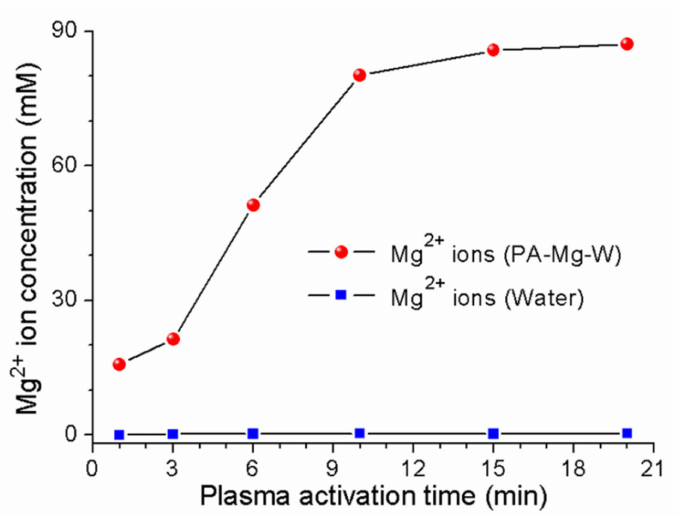
Figure 4. Mg 2 + ion concentrations in PA-Mg-W as a function of the plasma activation time. Red- colored circles and blue-colored squares represent Mg 2 + ion concentrations when the Mg block was immersed in water for 10 min with and without the plasma jet, respectively, and then the Mg block was excluded from